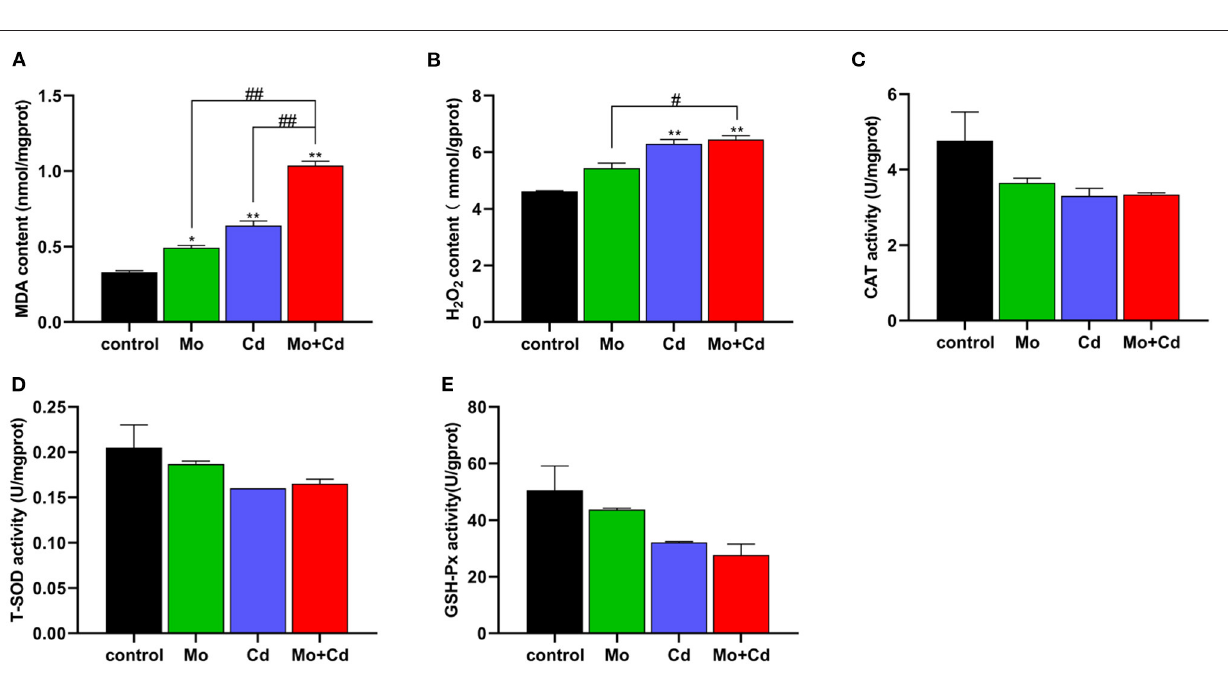
FIGURE 2 | Effect of Mo or/and Cd on oxidative stress of the kidney. (A) MDA content, (B) H 2 O 2 content, (C) CAT activity, (D) T-SOD activity, (E) GSH-Px activity. Data are expressed as means ± SD ( n = 6). “*” indicates significant difference compared to the corresponding control (* P < 0.05, ** P < 0.01). “#” indicates statistically significant difference between corresponding groups ( # P < 0.05, ## P < 0.01). co-location of COX IV and LC3 at day 50 is shown in FUNDC1 and p-FUNDC1 increased ( P < 0.05 or P < 0.01) Figures 6D,E . The green and red fluorescence signals overlapped markedly after Mo or/and Cd treatment at day 50 ( Figures 6B,C ), in all treatment groups, which indicated that LC3 were recruited but the variation had distinct alteration in the joint group to than those in single groups. The result of immunofluorescence